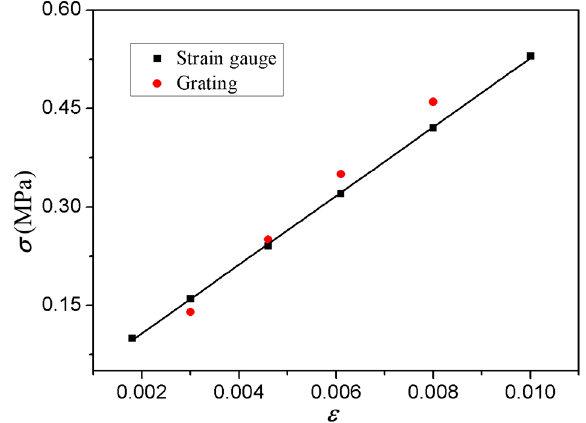
Figure 12. Stress-strain relation measured by strain gauge and gratings.